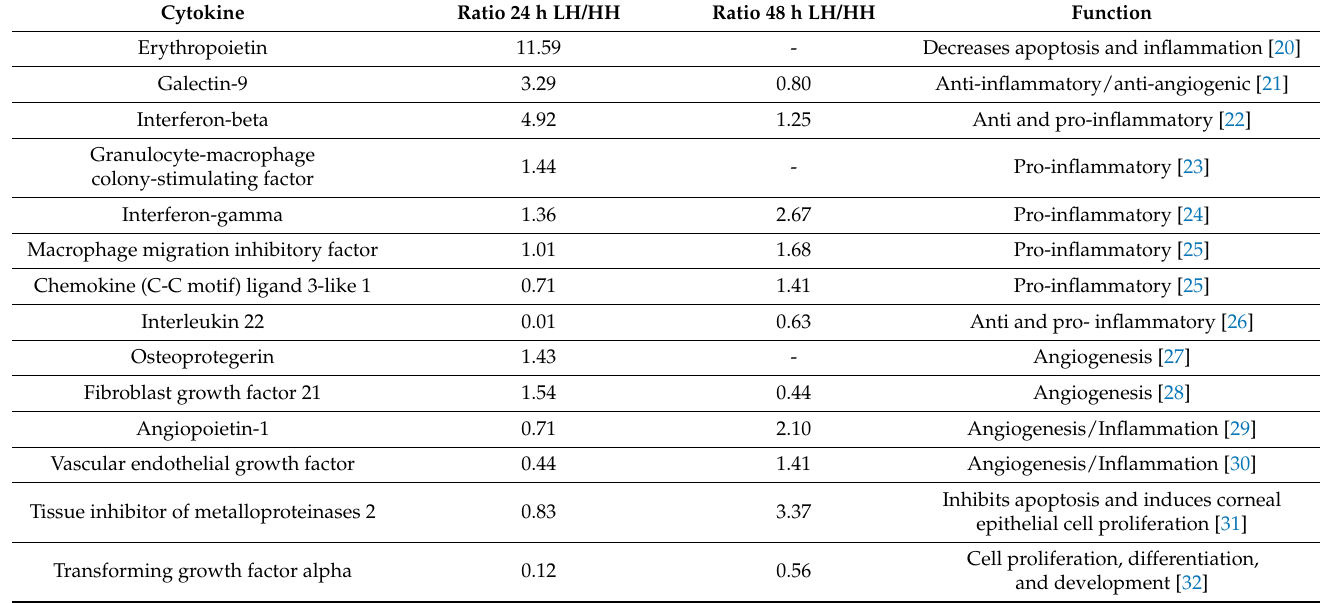
Table 1. Cytokines secreted in media of porcine corneas incubated at LH for 24 h and 48 h. Signal intensity ratio of each cytokine secreted at LH media was calculated in relation to HH and fold increase or decrease is demonstrated. LH: low humidity. HH: high humidity. -: ratio could not be calculated when signal intensity was lower than